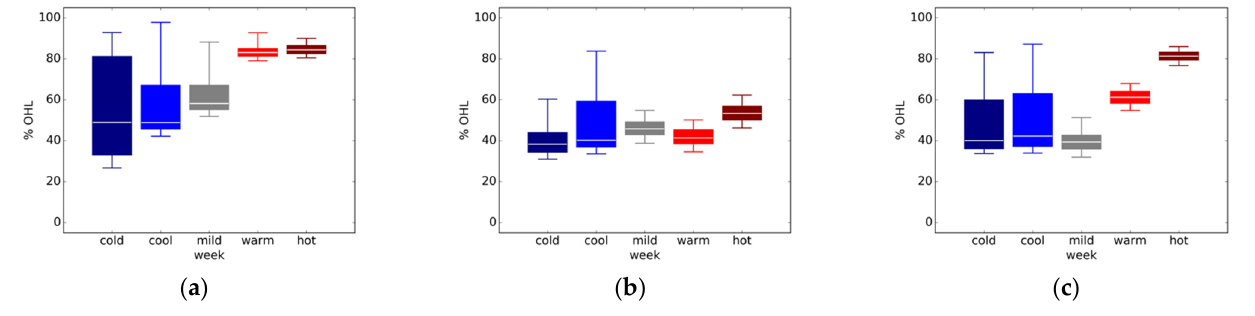
Figure 5. Overall OHL for Houston ( a ), San Francisco ( b ), Chicago ( c ).